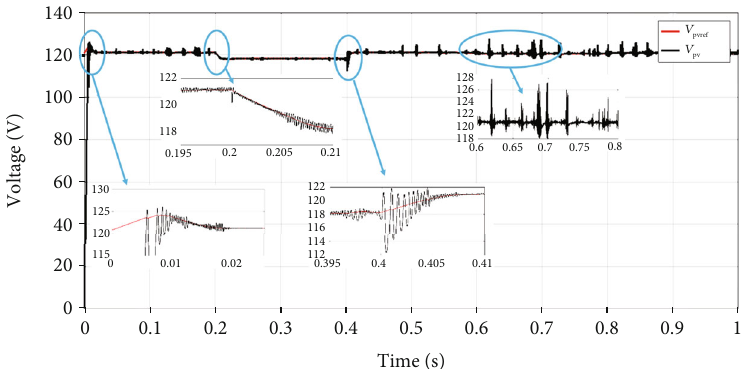
Figure 13: PV array voltage with its reference.